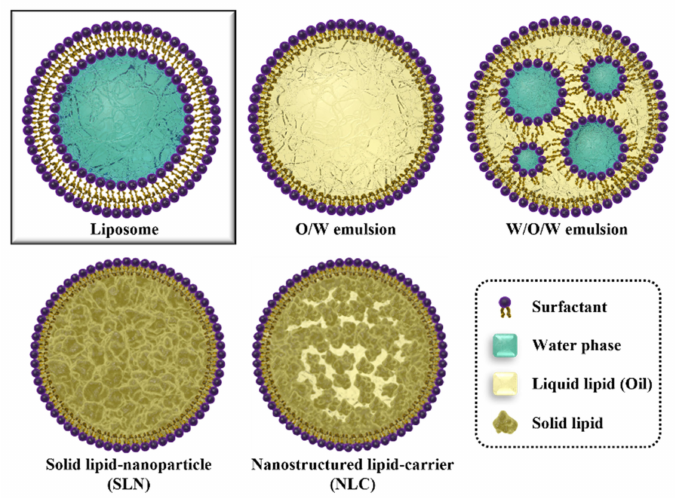
Figure 1. Conventional lipid-based colloidal carriers (liposome and various LNP